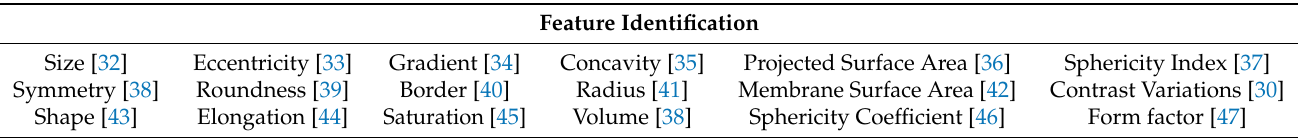
Table 1. Identifiable features using DIP